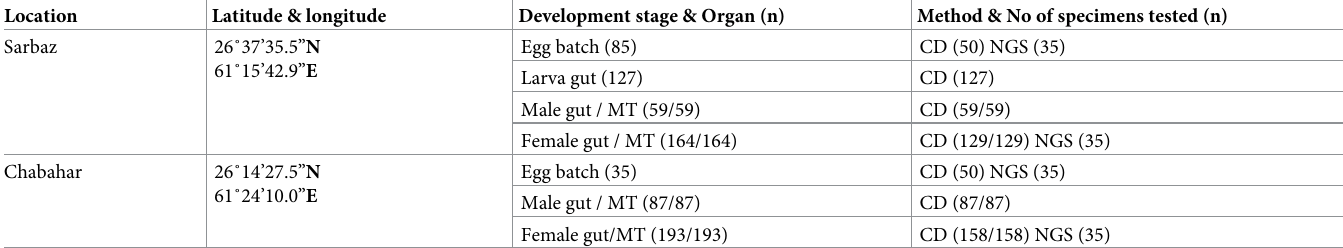
Table 1. Details of the H . anatolicum specimens collected for microbiome analysis.